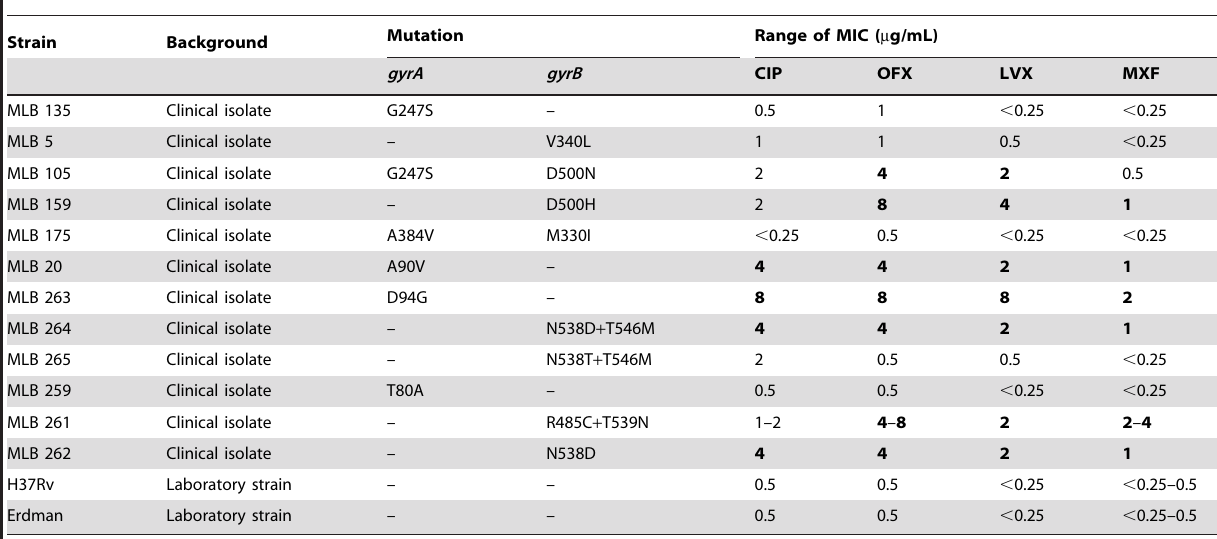
Table 1. List of M. tuberculosis isolates used in this